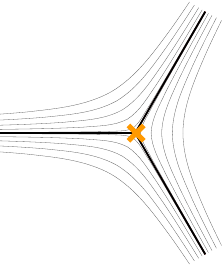
Figure 11 . The local structure of the WKB foliation for N = 2 around a branch point. The branch point is represented by an orange cross. The dark lines represent critical leaves, while the lighter curves are generic